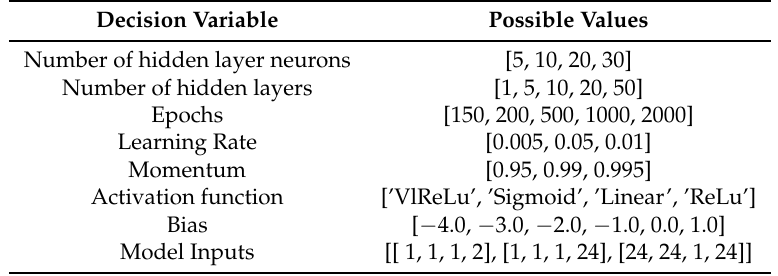
Table 2. Possible values of hyper-parameters defining the space explored by the genetic